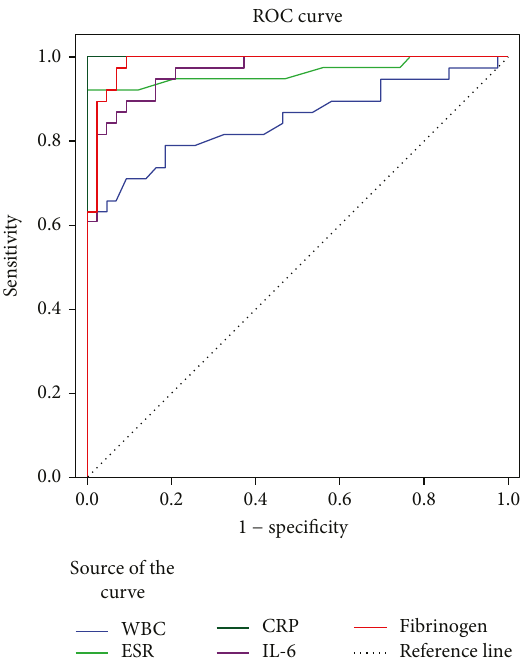
Figure 1: Receiver operating characteristic curves of in fl ammatory